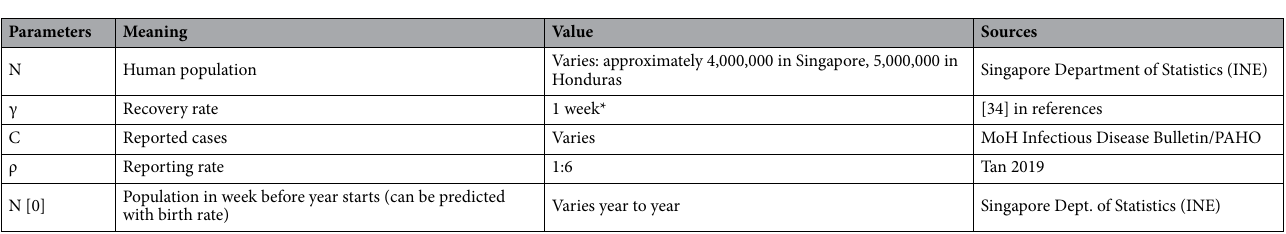
Table 8. Parameters of the SIR model that had known values and were not estimated using JAGS. MOH ministry of health, Dept. department, INE Instituto Nacional de